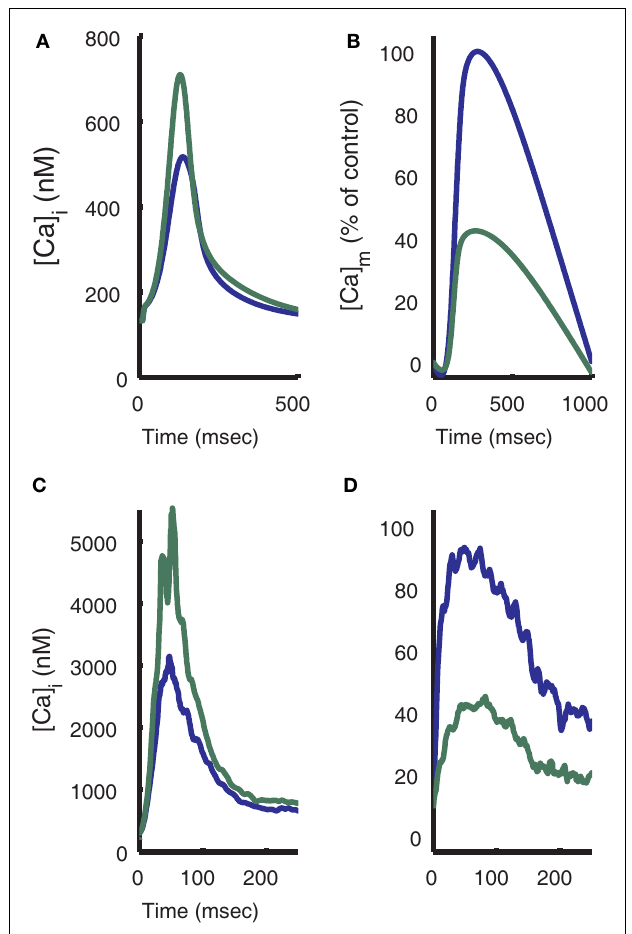
FIGURE 13 | Effect of mitochondrial uniporter block. (A) Model results show the effect of 75% block of the mitochondrial uniporter (simulated by reducing the parameterVmuni to 25% of its control value). Cytosolic Ca 2 + transient magnitude is increased and (B) mitochondrial Ca 2 + transient magnitude is decreased. Experimental data (Maack et al., 2006) for cytosolic Ca 2 + levels (C) and mitochondrial Ca 2 + levels (D) with addition of 10nM Ru, a blocker of the mitochondrial